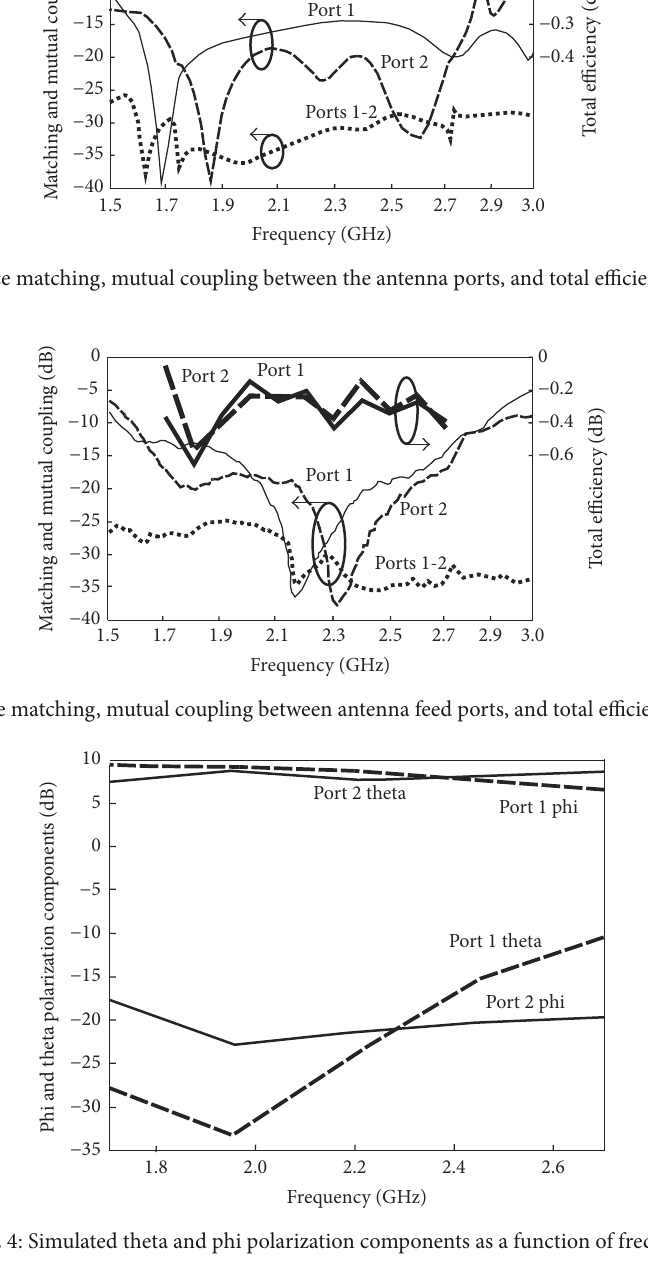
Figure 4: Simulated theta and phi polarization components as a function of